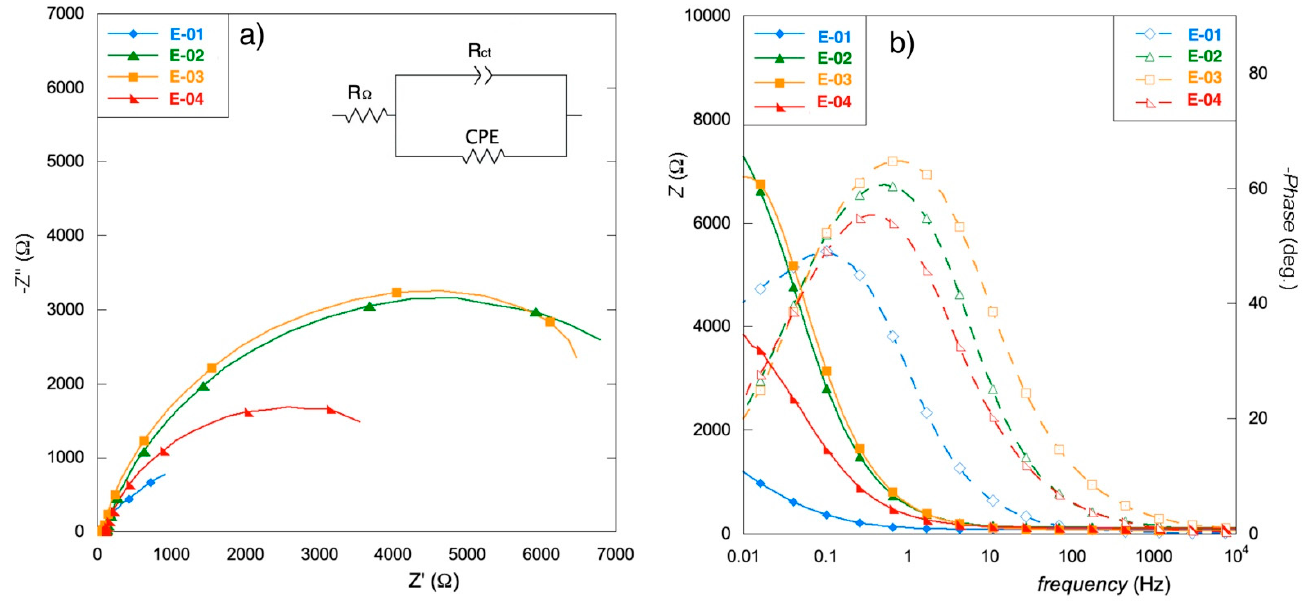
Figure 6. Nyquist ( a ) and Bode ( b ) diagrams of EIS spectra.